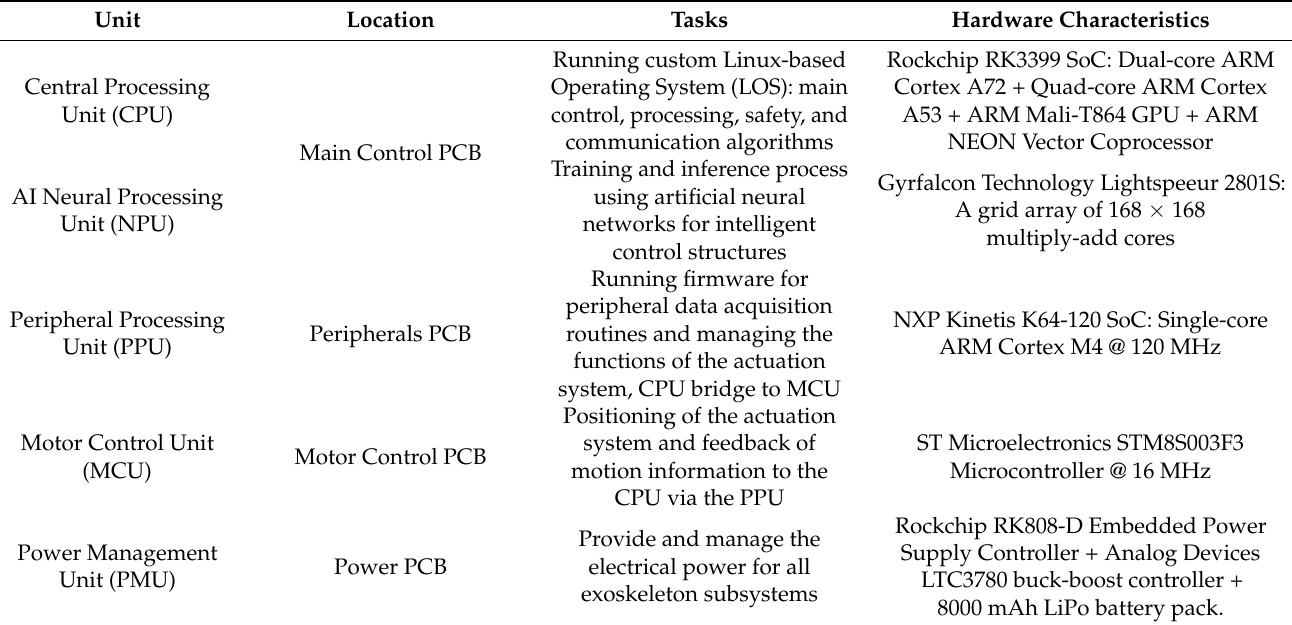
Table 3. Summary of the control hardware and processing architecture of the exoskeleton